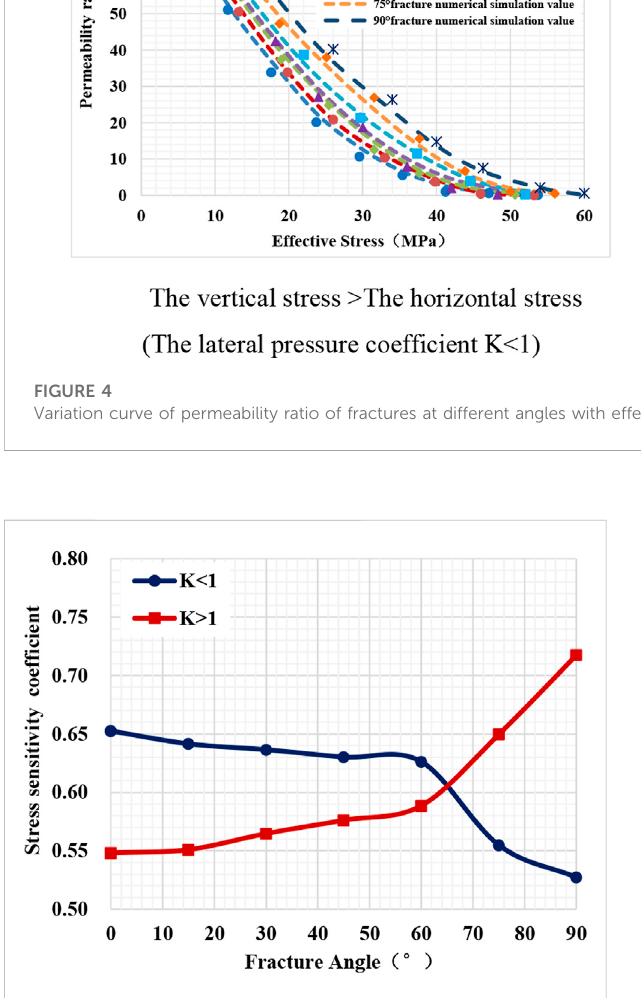
Curve of stress sensitivity coef fi cient changing with fracture